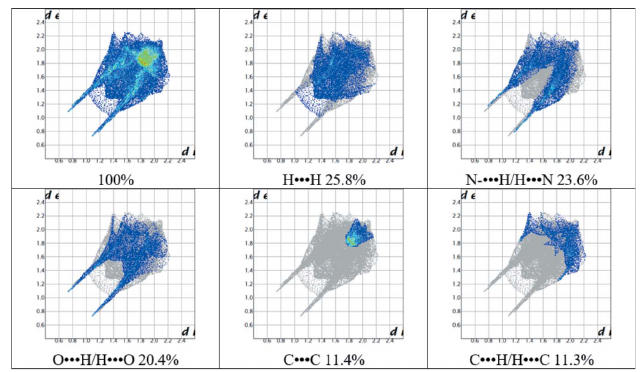
Figure 4 Hirshfeld surfaces for compound (I), mapped with d norm (top) and shape- index (bottom).